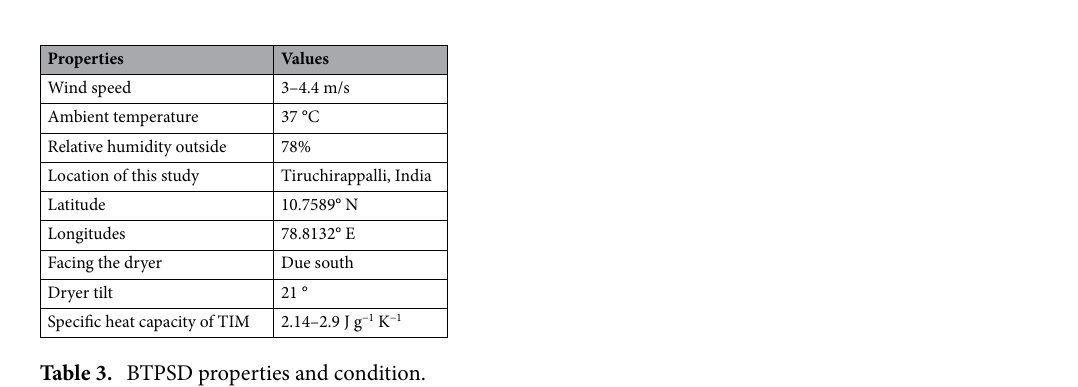
Figure 8. The schematic illustration of box-type passive solar dryer (BTPSD).